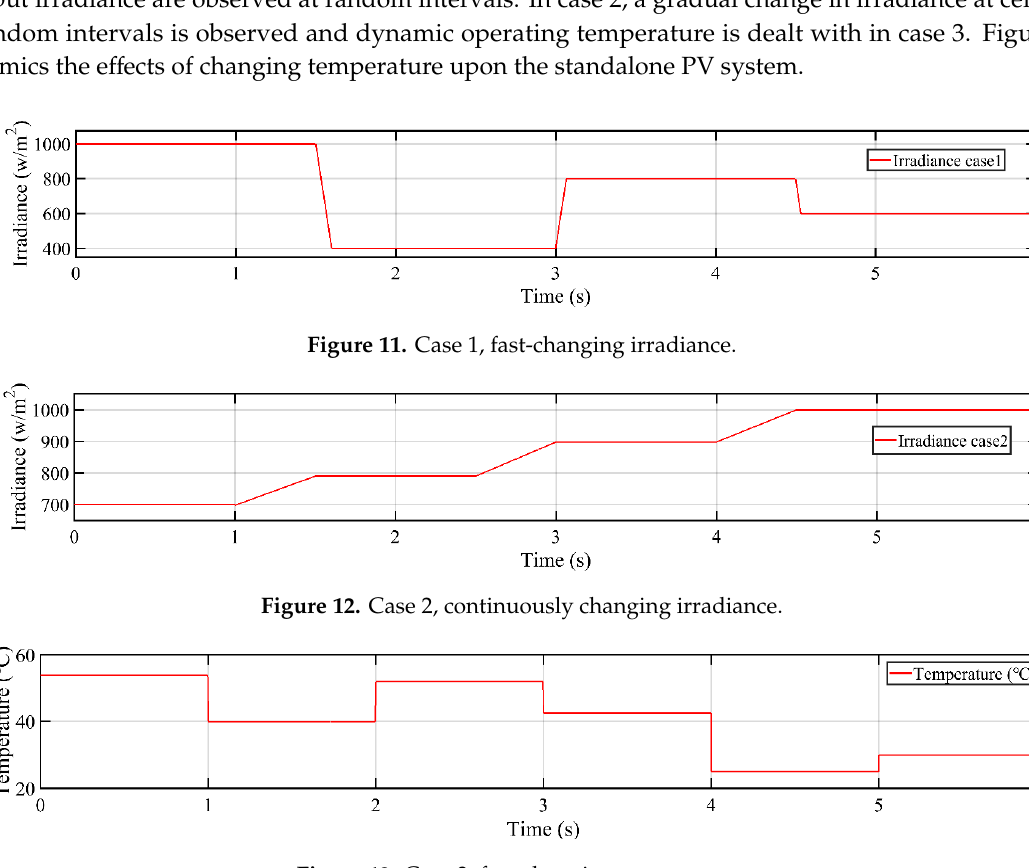
Figure 13. Case 3, fast-changing temperature.